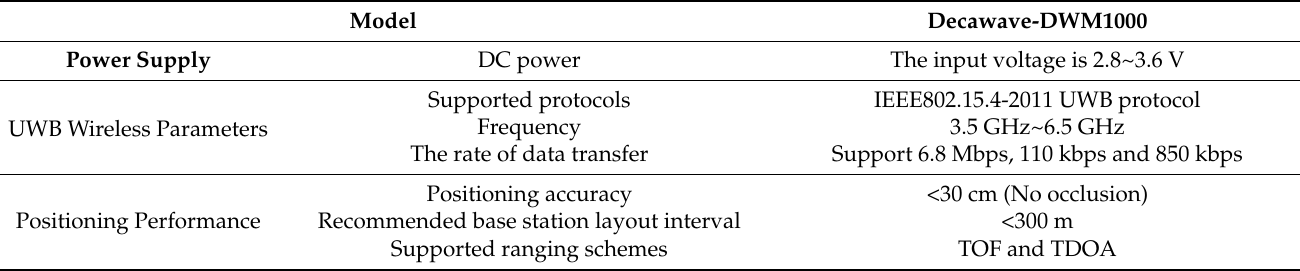
Table 1. Basic parameters of the base station and